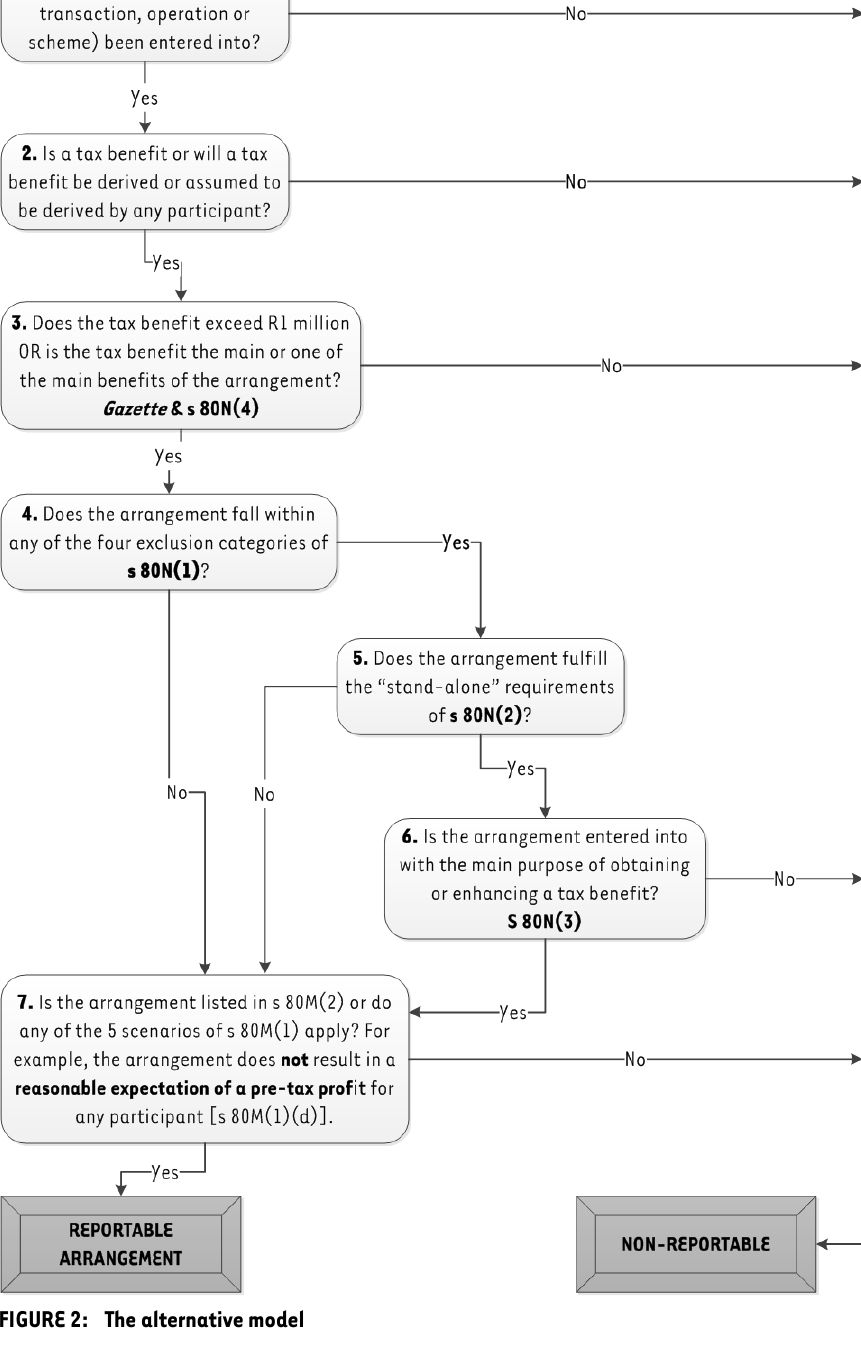
FIGURE 2: The alternative model